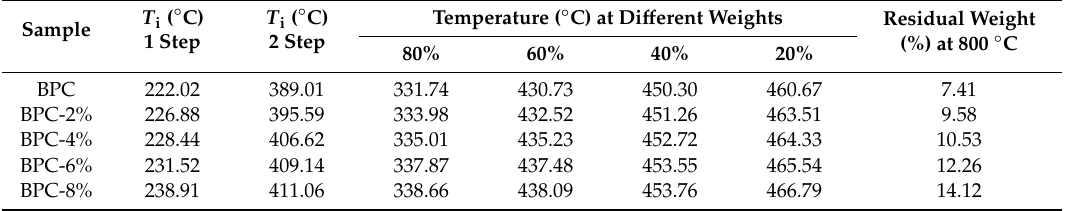
Table 1. Thermogravimetric analysis (TGA) results of the BPC samples.